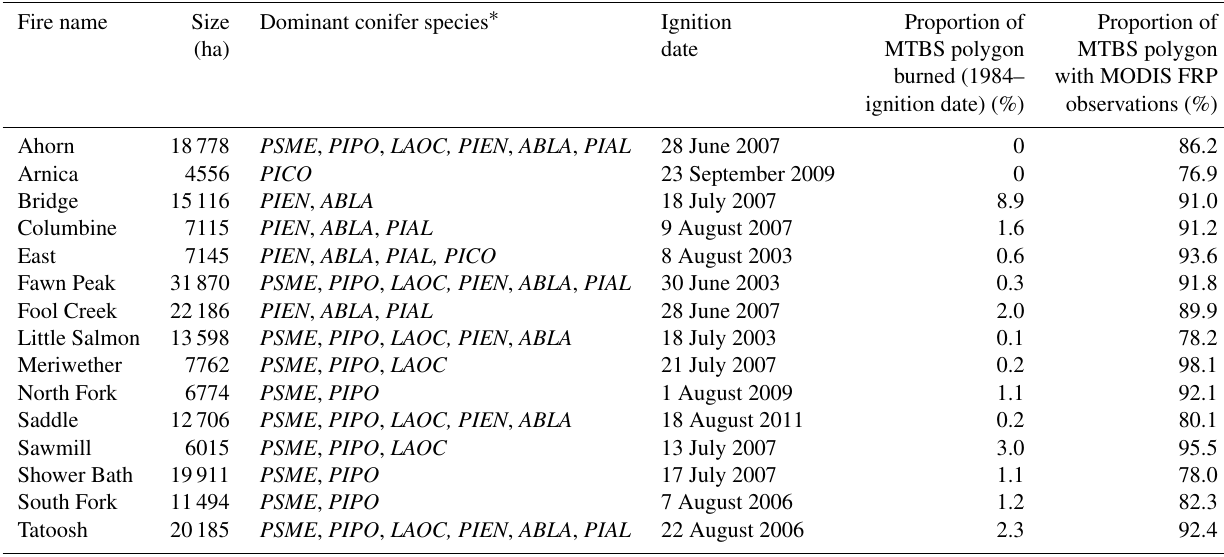
Table 1. Summary of the 15 fires analyzed in this study.